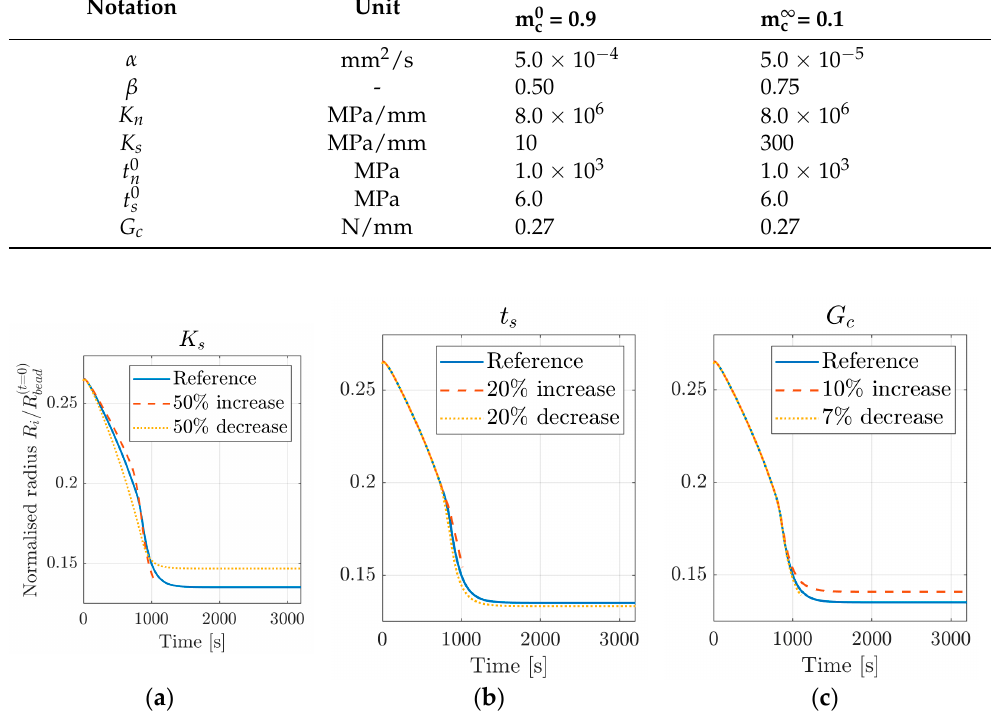
Figure 8. Parameter variations for ( a ) the cohesive stiffness in the shear direction K s , ( b ) the cohesive strength in the shear direction t 0 s , and ( c ) the fracture energy G c . The reference curves correspond to the values given in Table 2.